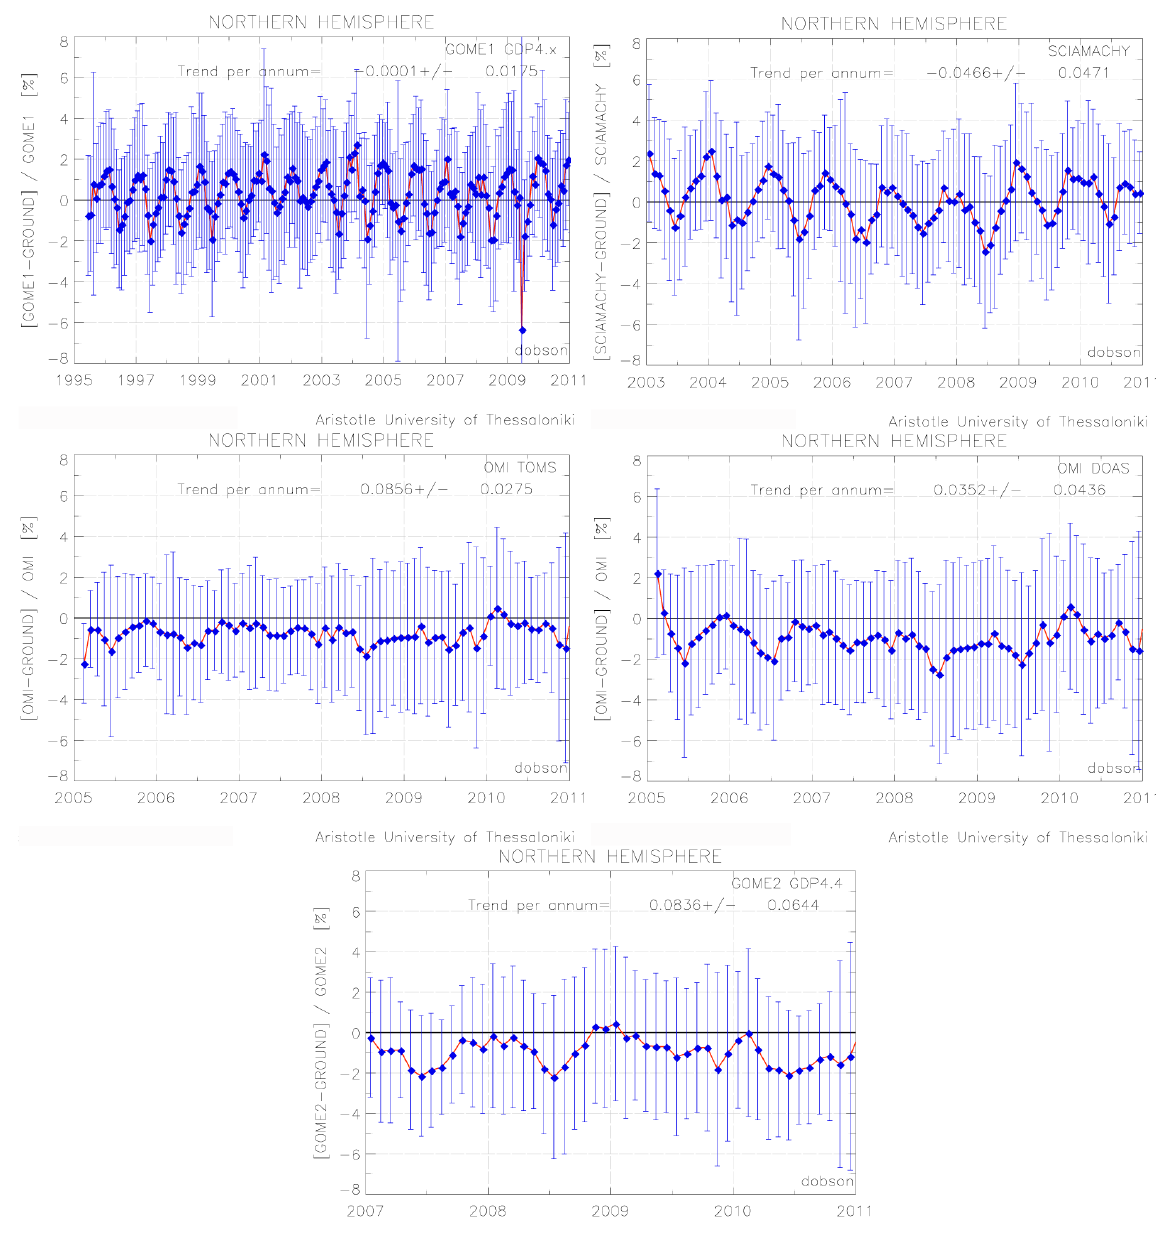
Fig. 2. Time series of the differences between satellite and Dobson ground-based measurements for the five datasets for the Northern Hemisphere stations only. Top left: GOME. Top right: SCIAMACHY. Middle left: OMI TOMS. Middle right: OMI DOAS. Bottom: